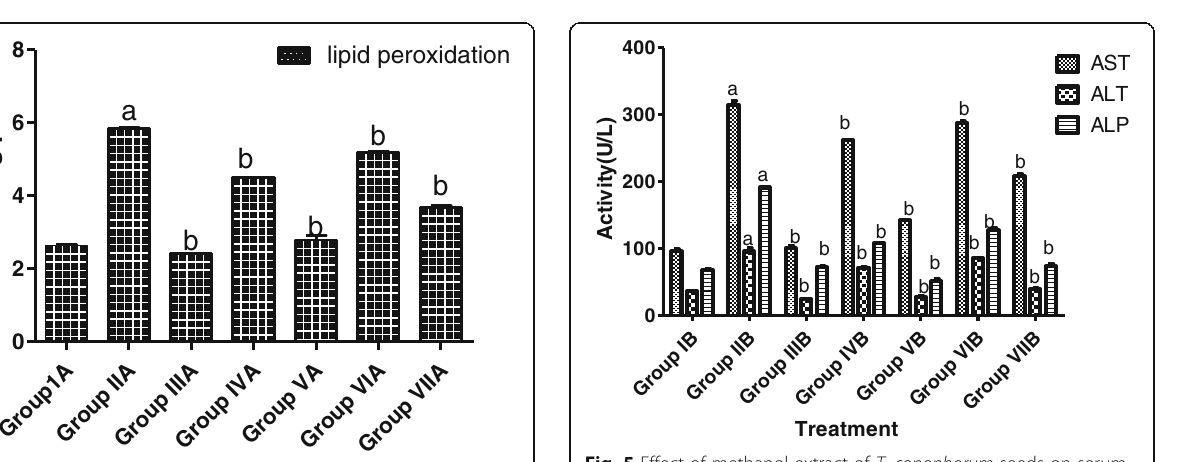
Fig. 5 Effect of methanol extract of T. conophorum seeds on serum Aspartate aminotransferase, Alanine aminotransferase and Alkaline phosphatase activities in CCl 4 induced hepatotoxicity in rats after 48 h of intoxication. Values are Mean ± SEM, n = 5 rats in each group. p < 0.05, a as compared with the normal control group; b as compared with the CCl 4 only (group IIB). AST- Aspartate aminotransferase; ALT- Alanine aminotransferase; ALP - Alkaline phosphatase; CCl 4 - Carbon tetrachloride. Group IB (control) received distilled water and olive oil (i.p), group IIB rats were intoxicated with CCl 4 in olive oil (600 mg/kg, i.p.) only on the 8th day, while groups IIIB, IVB and VB were given 100 mg/kg of silymarin, 250 mg/kg and 500 mg/kg of methanol extract respectively for 7 days, thereafter intoxicated with CCl 4 on the 8th day. Groups VIB and VIIB were intoxicated with CCl 4 on the 8th day and administered 250 mg/kg and 500 mg/kg of methanol extract of T. conophorum seeds at 1 h, 6 h, 12 h, 18 h and 24 h. Fasting blood samples were collected after the last administration of the extract at 48 h of intoxication with CCl